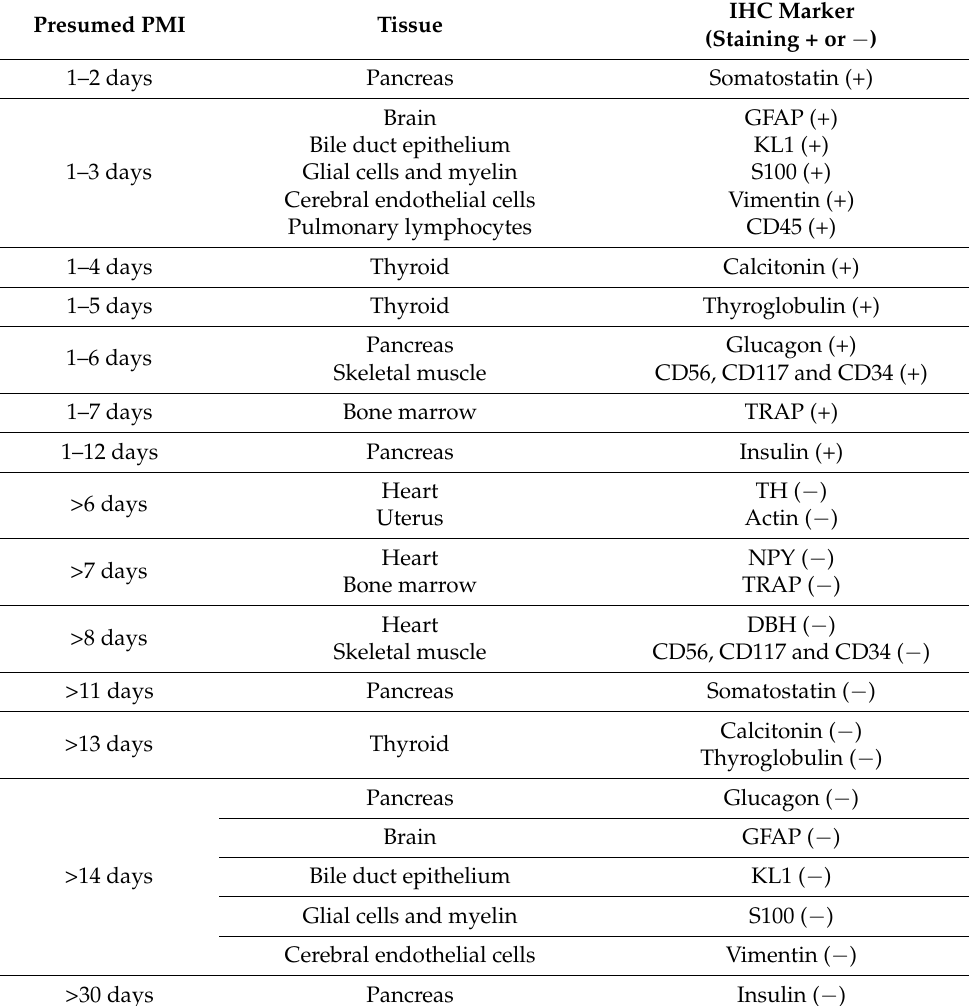
Table 2. IHC markers in relation to the presumed PMI. Each antigenic marker undergoes changes in IHC expression associated with the PMI. After estimation of the time since death through traditional methods, it is necessary to use the most suitable IHC markers to estimate the PMI as accurately as possible. An IHC analysis can be performed for any suspected PMI, especially in the first 2 weeks after death. Abbreviations: PGP, Protein gene product; DBH, Dopamine β -hydroxylase; TH, Tyrosine hydroxylase; NPY, Neuropeptide Y; GFAP, glial fibrillary acidic protein; NF- κ B, nuclear factor kappa B; TRAP, Tartrate-resistant acid phosphatase; HIF 1-alfa, Hypoxia-inducible factor 1-alpha; cTnC, cardiac Troponin C; HMGB1, High-mobility group